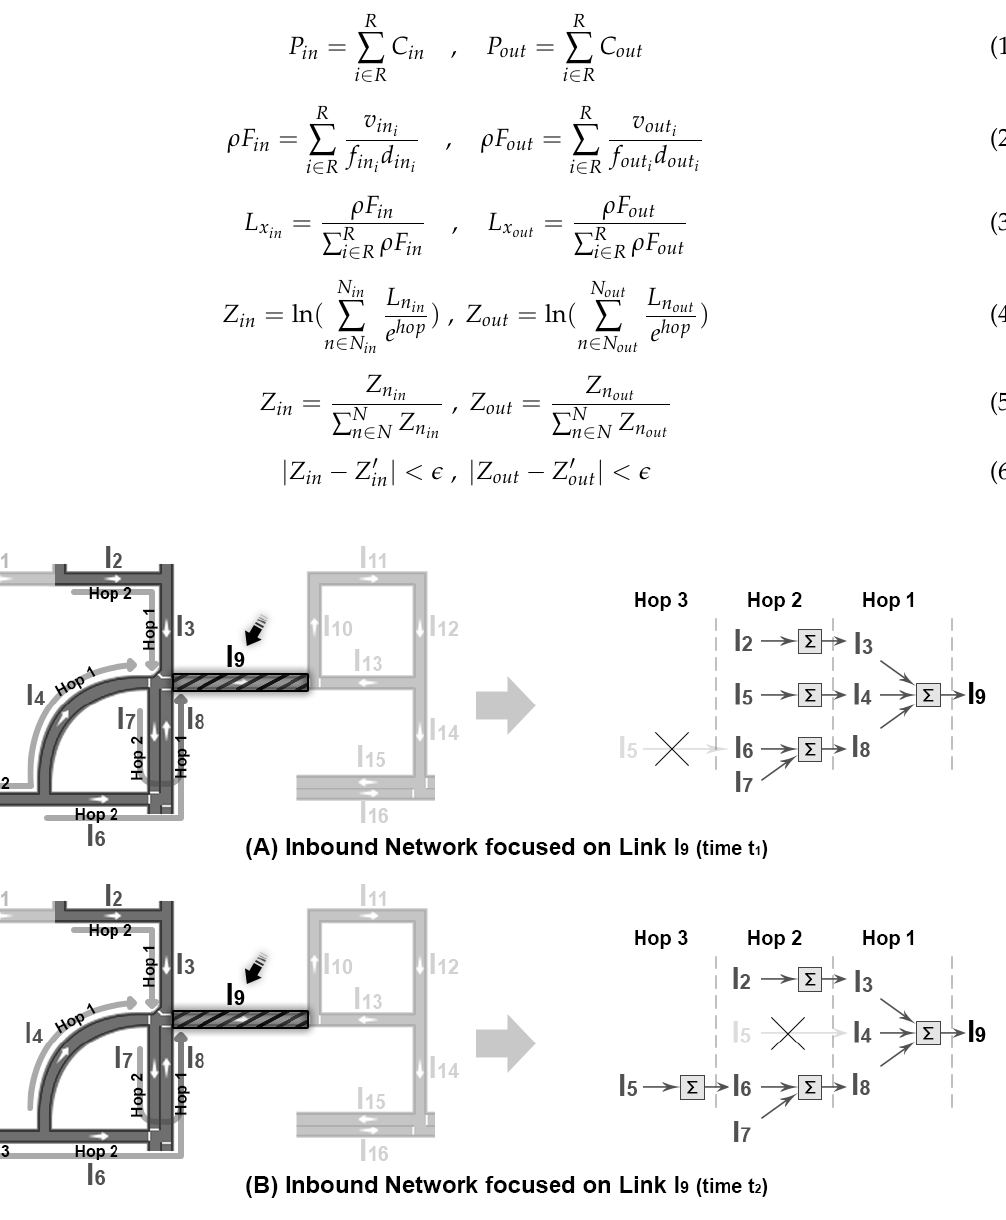
Figure 4. Extraction of inbound reachable paths and the computation of the inbound Z value for I 9 .